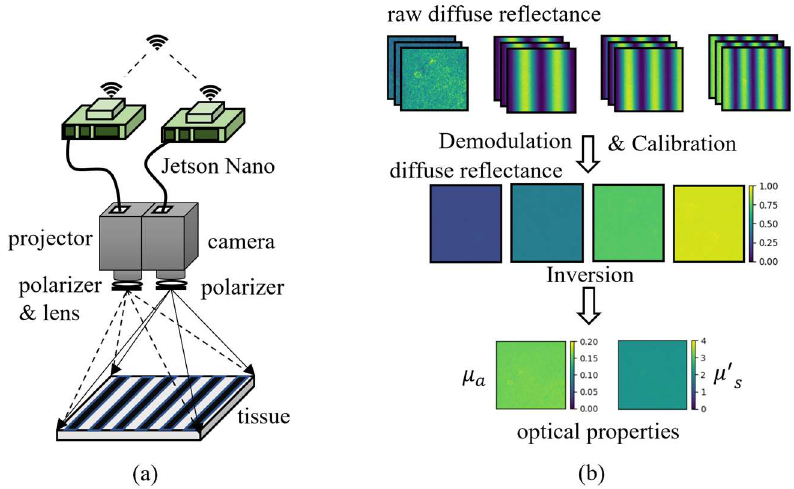
Figure 1. ( a ) for SFDI instrumentation and ( b ) for data processing.